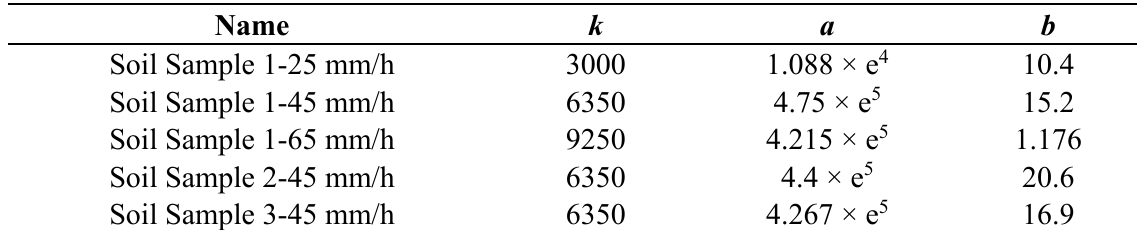
( e ) Figure 12. S-growth curve fitting: ( a ) soil Sample 1-25 mm/h; ( b ) soil Sample 1-45 mm/h; ( c ) soil Sample 1-65 mm/h; ( d ) soil Sample 2-45 mm/h; and ( e ) soil Sample 3-45 mm/h. Table 1. Parameters of five S-shaped growth